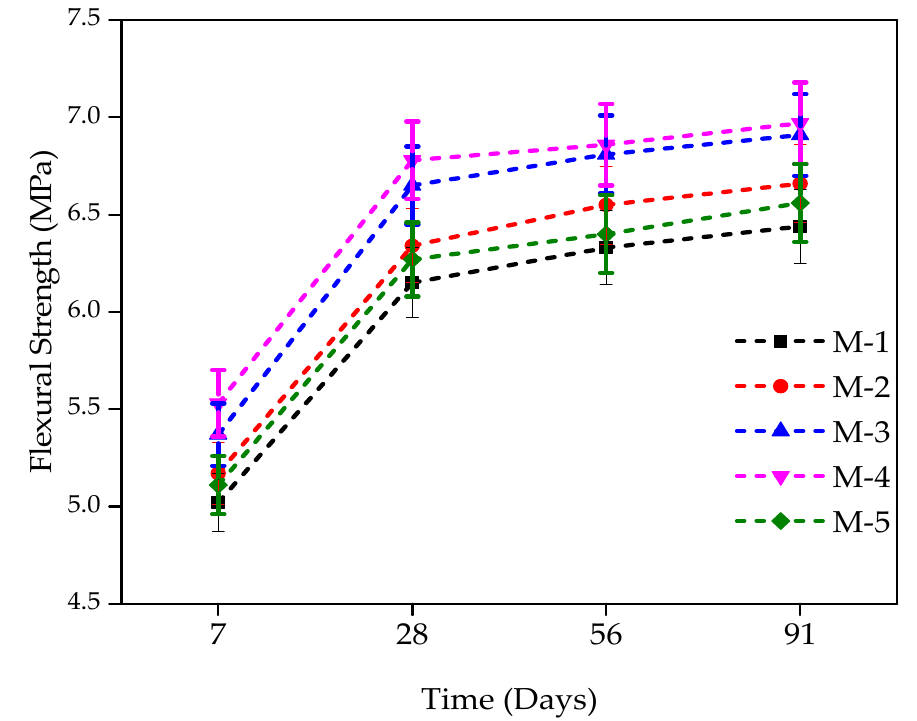
Figure 6. Flexural strength development of WFS concrete at di ff erent days [49].